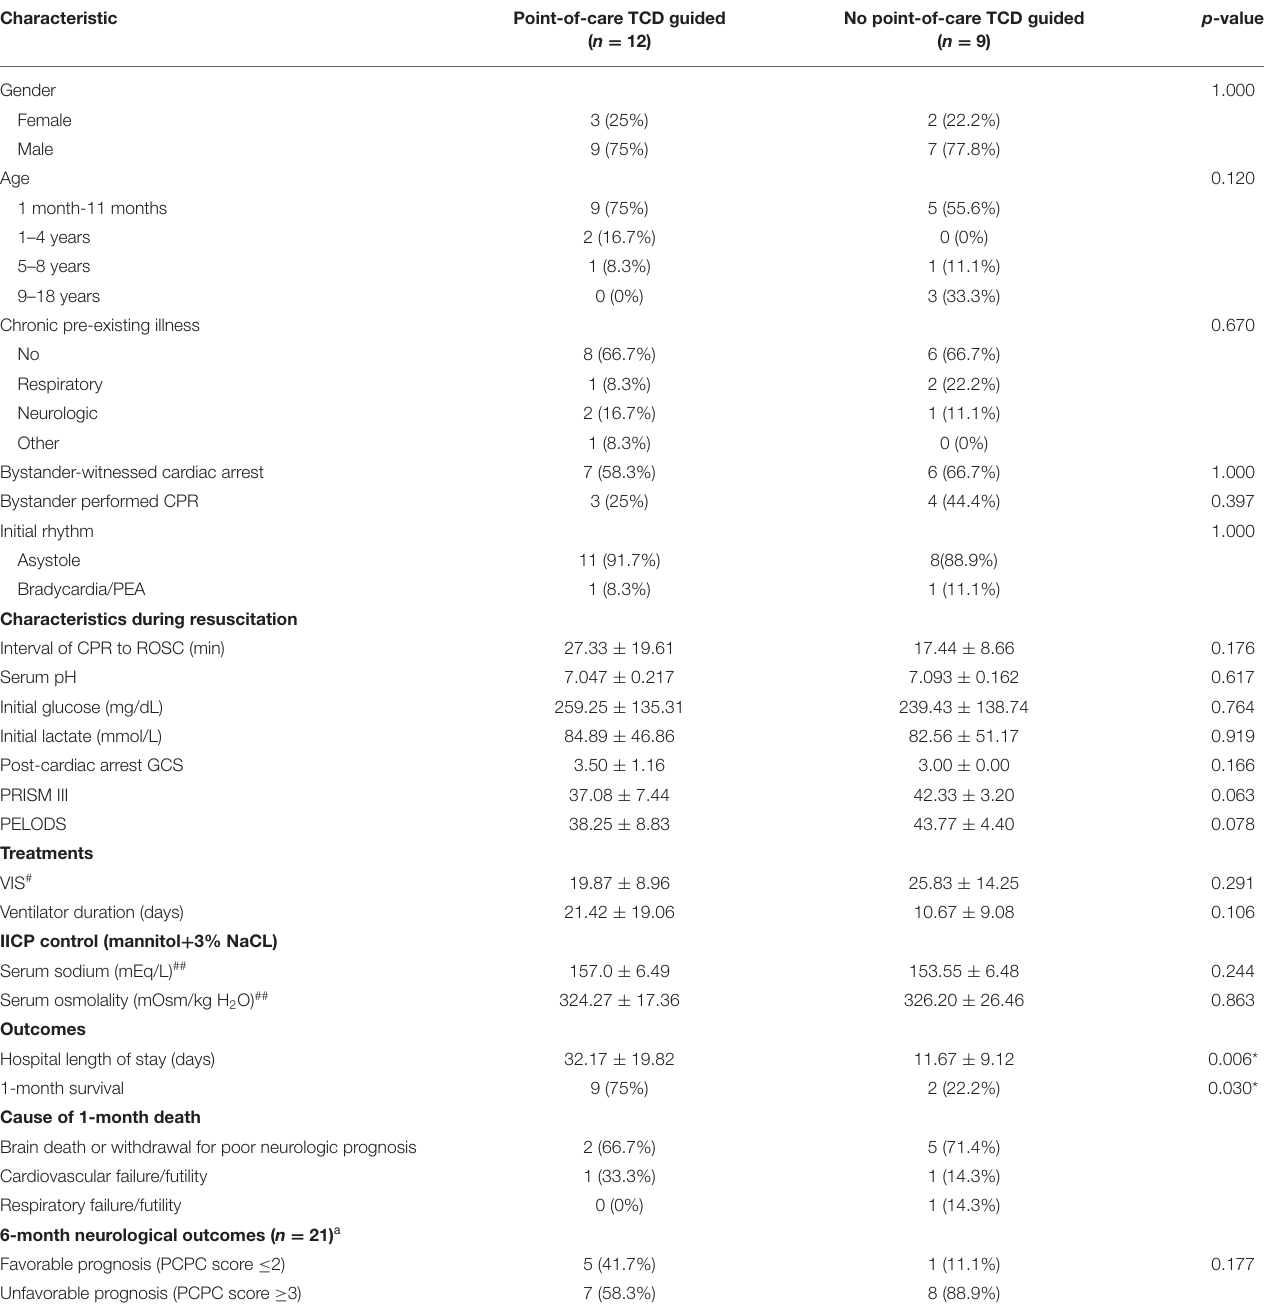
TABLE 1 | Characteristics of the 21 children with asphyxial out-of-hospital cardiac arrest receiving therapeutic hypothermia. Characteristic Point-of-care TCD guided